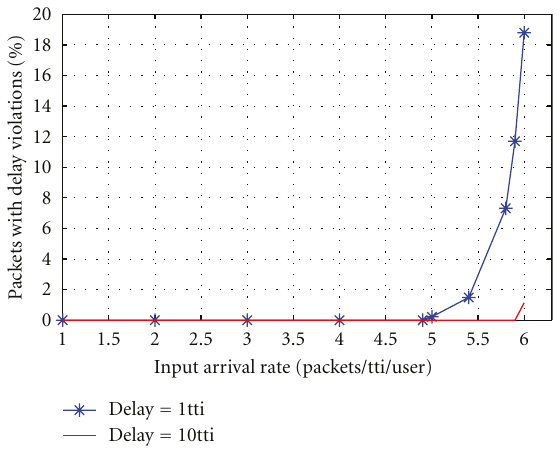
Figure 7: Percentage of packets with delay deadline violations for worst user versus delay constraint achievement probability. Users = 14, Subcarriers = 40, Input arrival rate = 6 packets/tti, Cell Radius = 700 m, and tti = 1ms.